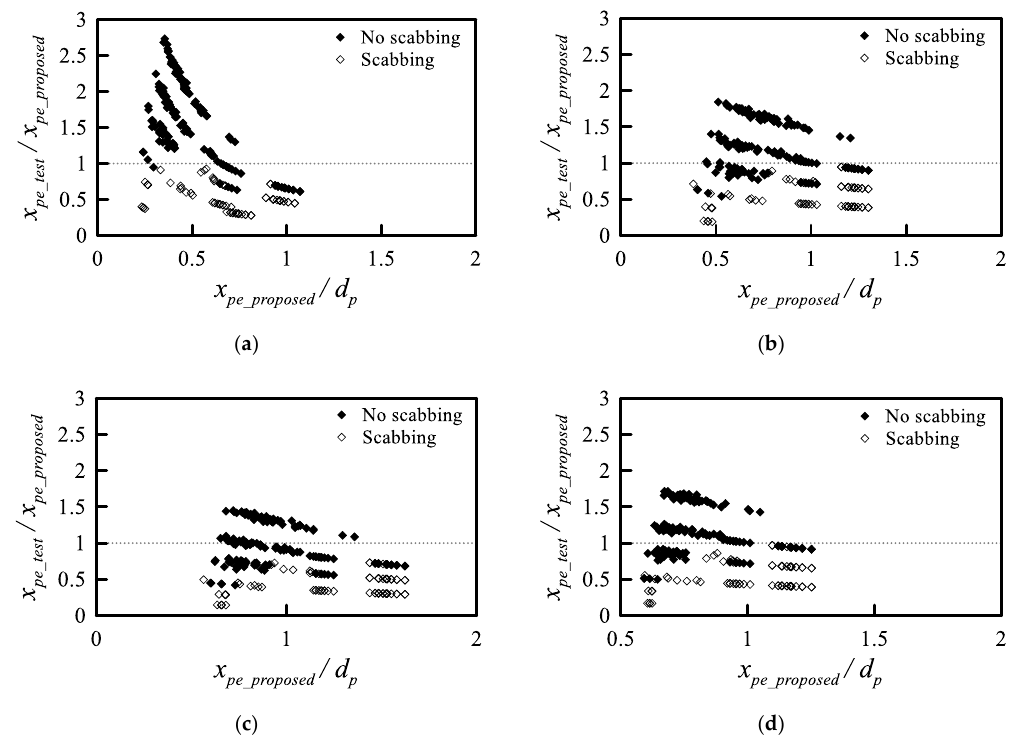
Figure 9. ( a ) Proposed formula; ( b ) modified National Defense Research Committee (NDRC); ( c ) Hughes formula; ( d ) Army Corps of Engineers (ACE) formula. Panel thickness ( h ) divided by predicted scabbing limit thickness ( h sc ).